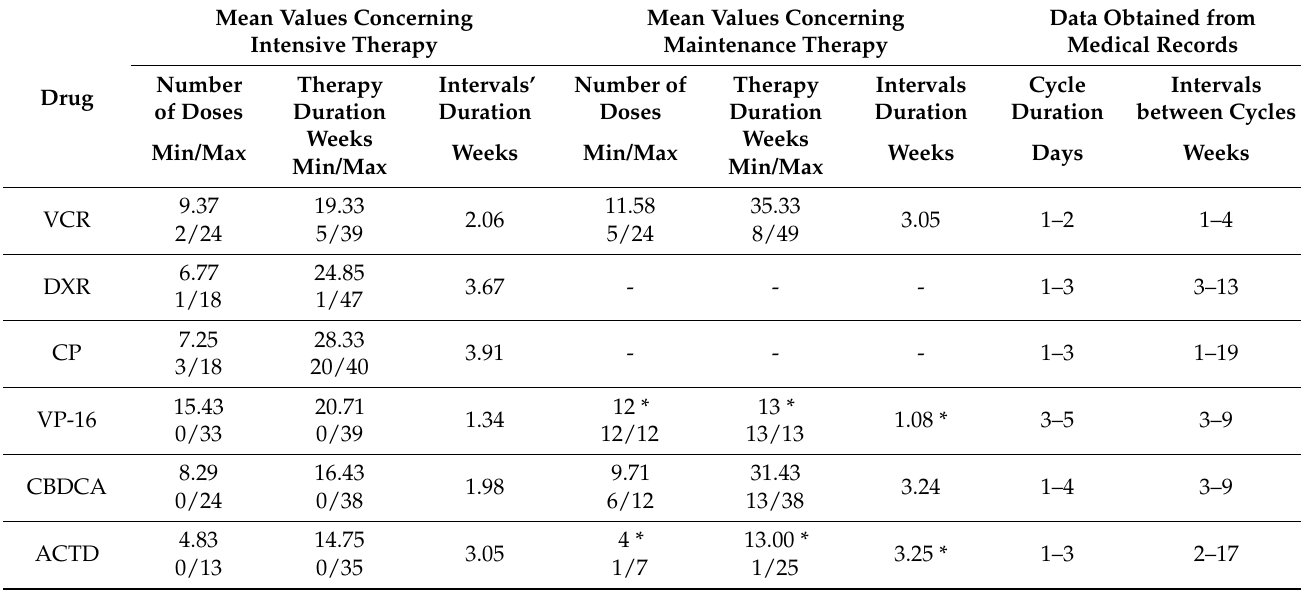
Table 6. Drugs’ administration